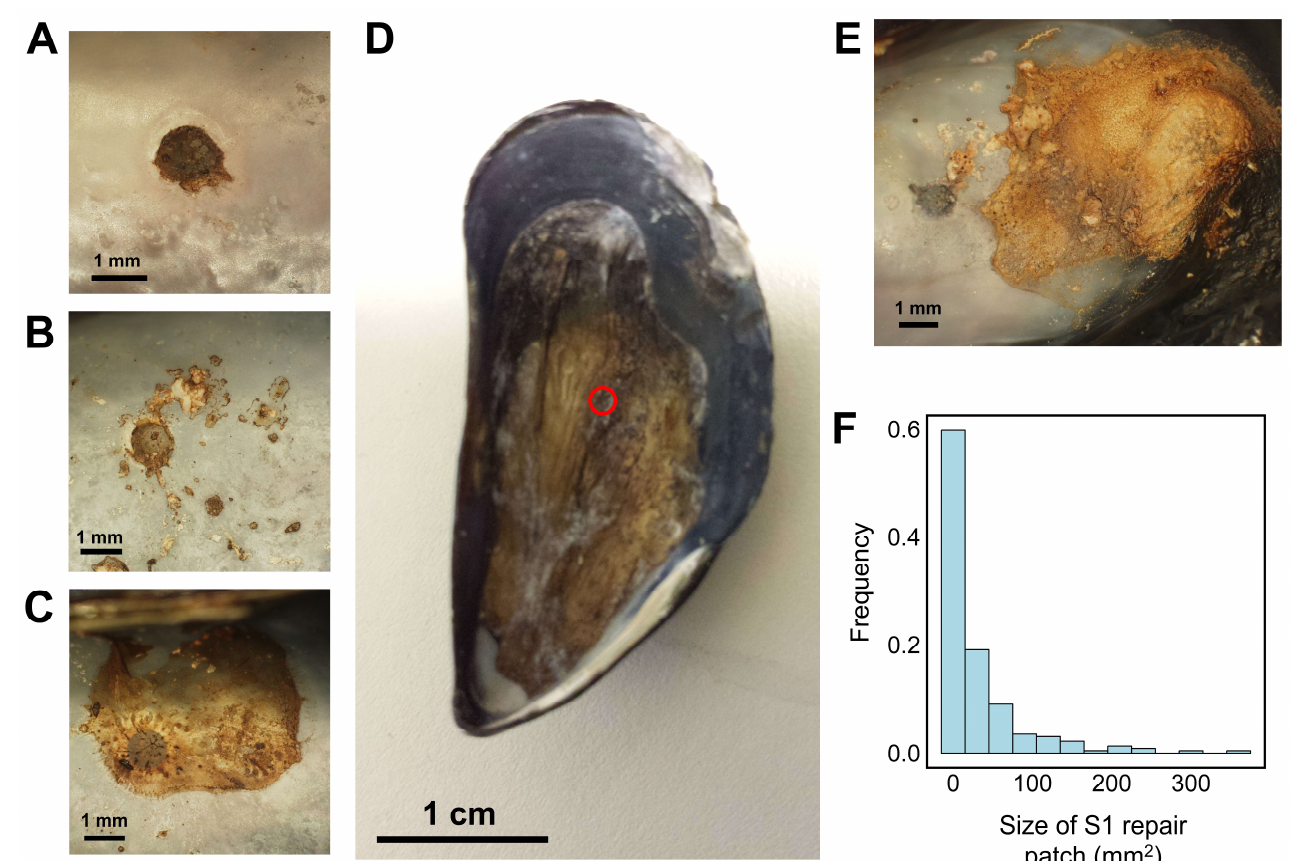
Figure 3. Examples of variable response to shell damage during Stage 1 (S1; M. edulis ). Some mussels deposited organic matrix neatly within the shell defect ( A ), while others applied repair patches over a greater area ( B , C ). In rare cases, the organic matrix encompassed the entirety of the valve interior (( D ), red circle indicates location of drill hole), while others produced matrix away from the shell injury altogether ( E ). The frequency distribution of repair patch size during S1 ( F ).